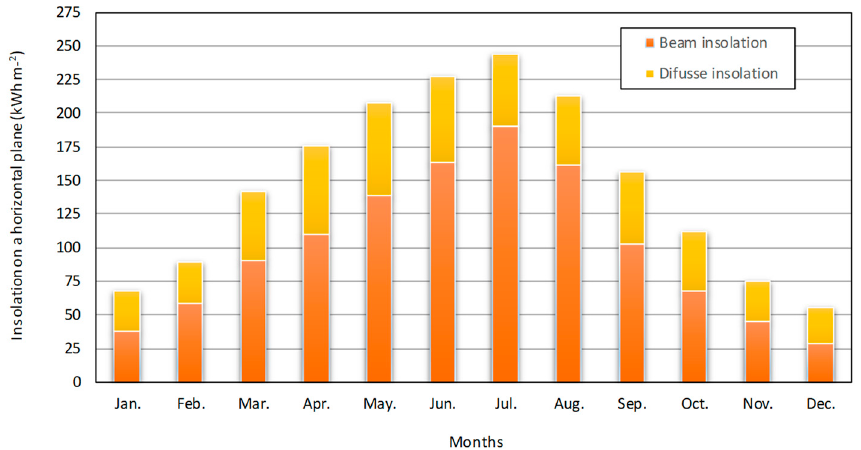
Figure 2. Beam, diffuse and global insolation on a horizontal plane for the selected location (kWh · m − 2 ).